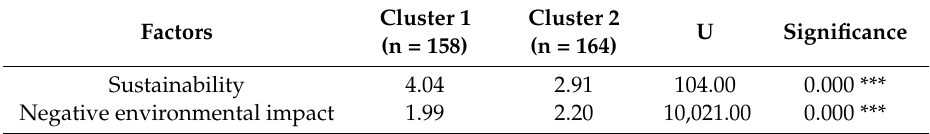
Table 5. Mean of